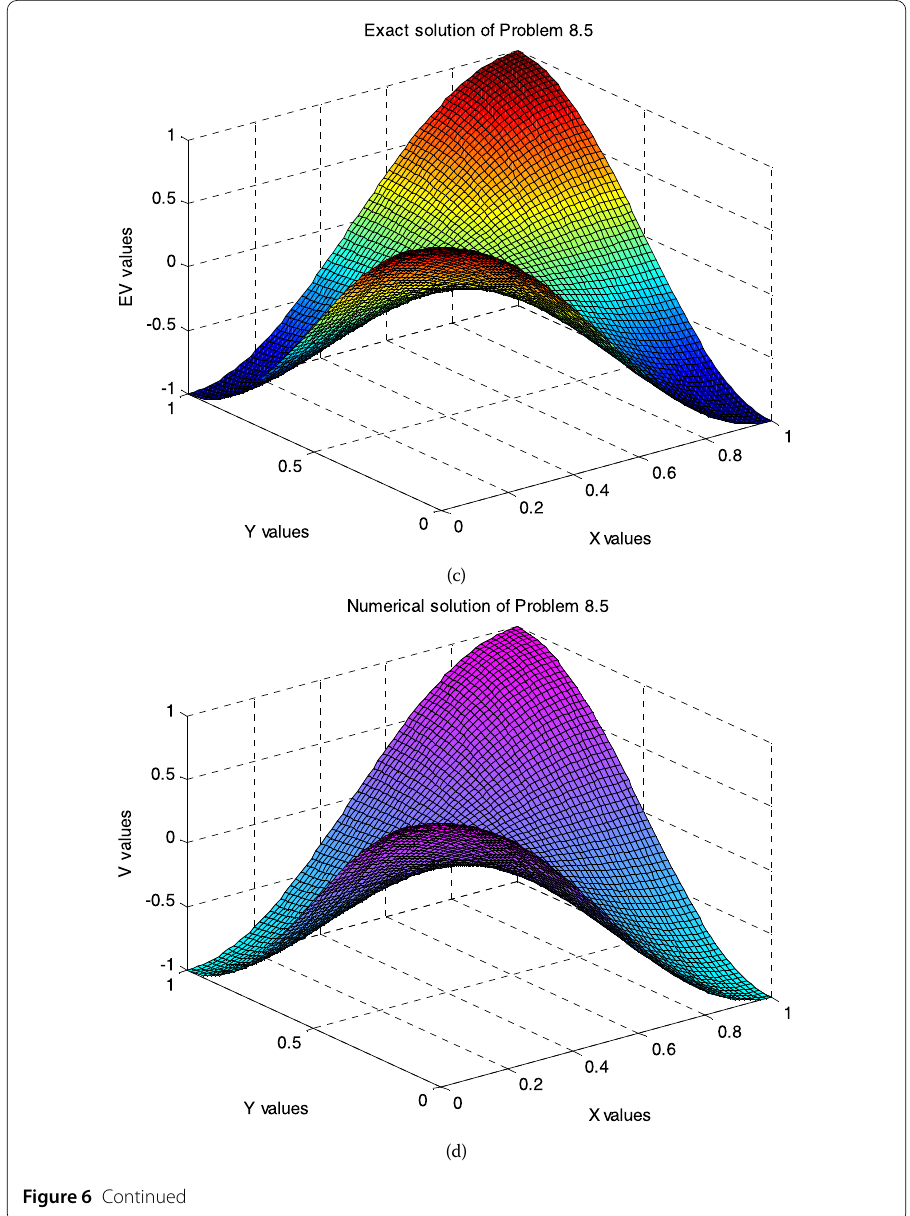
The exact solution is z ( x , y ) = sin ( π x ) cos ( π y ). The MAEs in z are tabulated in Table 9 for various values of α . Figures 10(a) and (b) give the plots of the exact and numerical solutions of z for h = 1/64 and α =